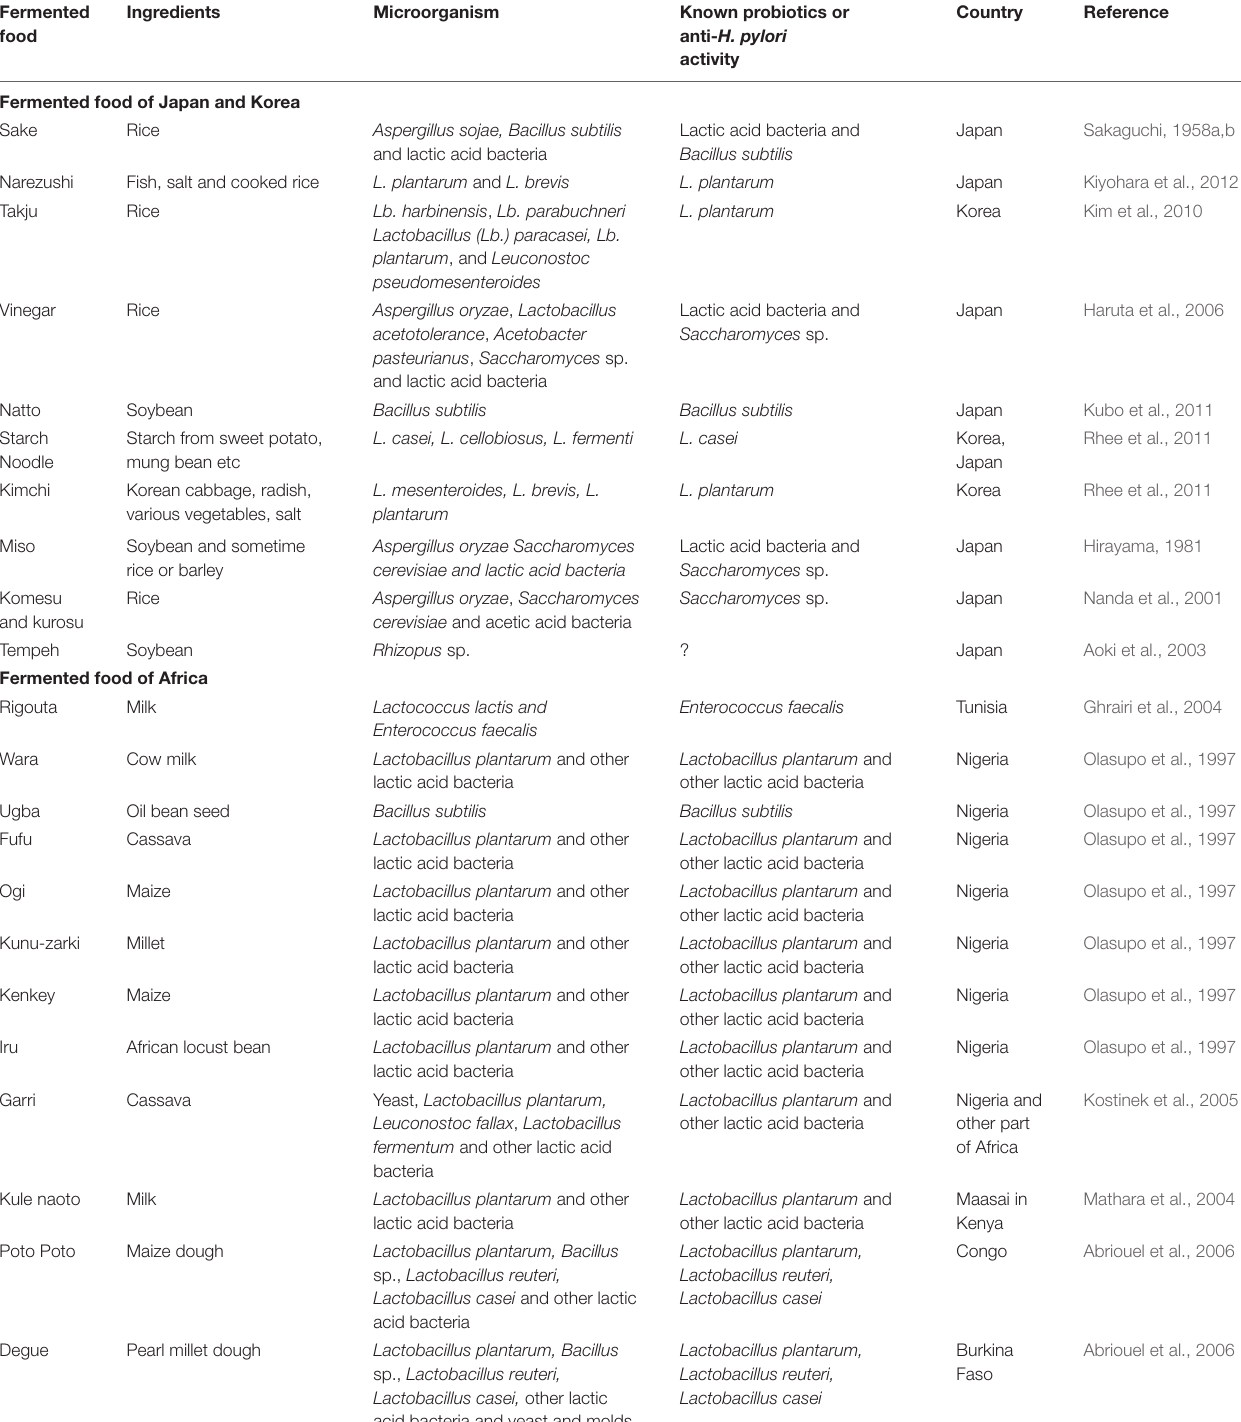
TABLE 2 | Microbes present in traditional fermented foods and beverages in Japan and